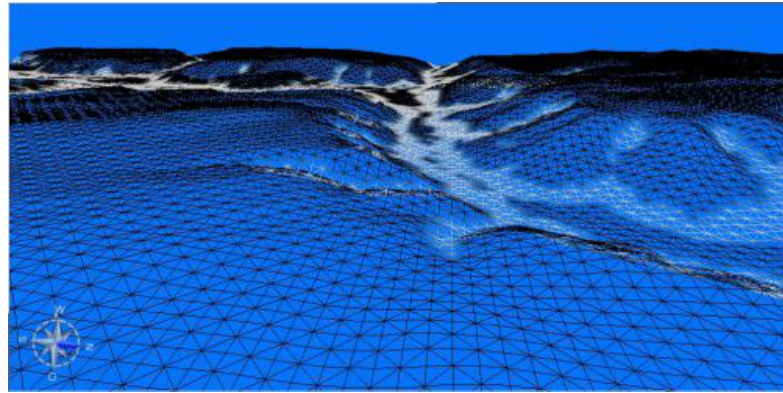
Figure 12. Pixels with the lowest elevation (white) along identified cross-sections draped onto the wired mesh of